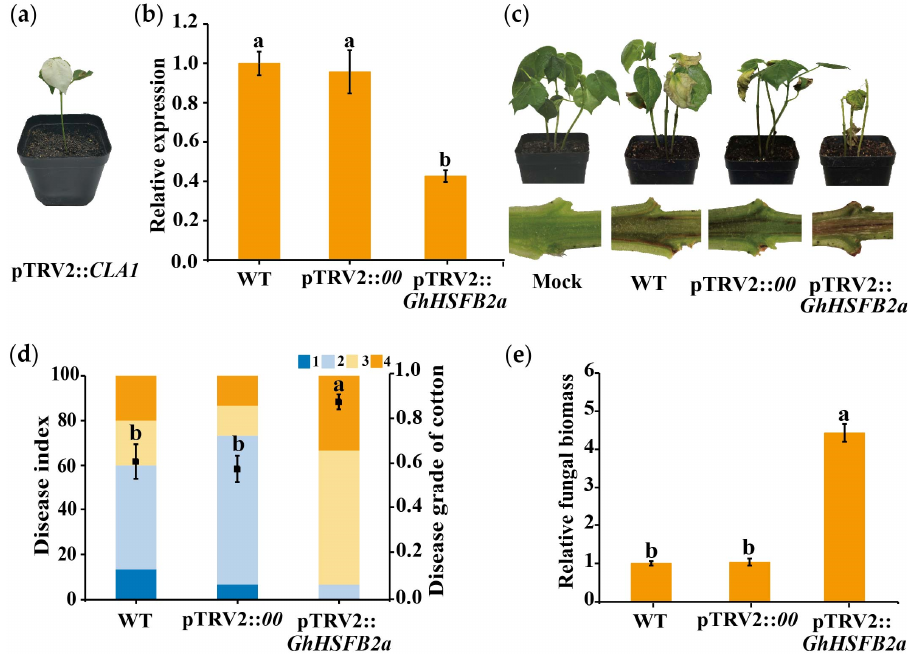
Figure 4. Silencing of GhHSFB2a attenuates plant resistance to V. dahliae . ( a ) Seven ‐ day ‐ old cotton plants were infiltrated with Agrobacterium tumefaciens carrying pTRV2:: CLA1 . The photographs were taken two weeks after infiltration. ( b ) Preliminary assay of the efficiency of VIGS under our experimental conditions. Expression of GhHSFB2a in pTRV2:: GhHSFB2a and control plants. Gossypium hirsutum polyubiquitin was the internal reference gene ( p < 0.05; 2 −ΔΔ Ct ). ( c ) Disease phenotypes of GhHSFB2a ‐ silenced plants infected with V991 at 14 days post ‐ inoculation (dpi). ( d ) Disease index of pTRV2:: GhHSFB2a and control plants at 14 dpi with V. dahliae . 1, 2, 3, and 4 represent the disease degree. ( e ) Fungal biomass determined using qRT ‐ PCR at 14 dpi with V. dahliae . Error bars represent the standard deviations and different letters indicate significant differences at p < 0.05.